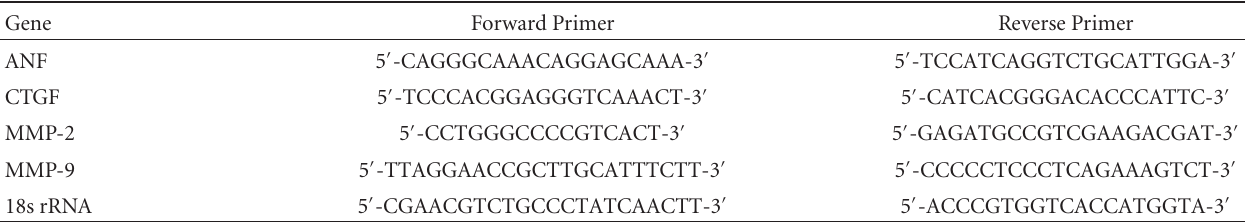
Table 1: Primers used for real-time